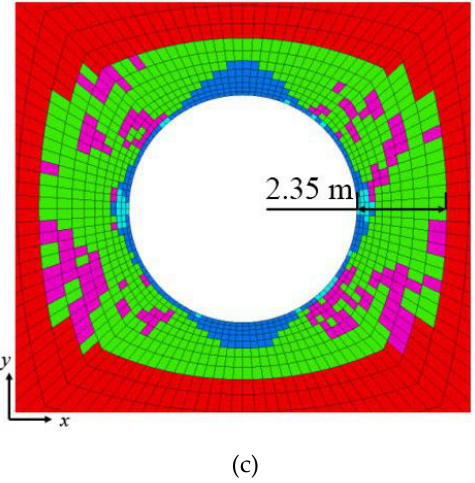
Figure 6. Elastoplastic numerical simulation results of the shaft rock at − 1276 m. ( a ) Contour of major principal stress. ( b ) Contour of maximum displacement. ( c ). Contour of plastic zone of wall rock.